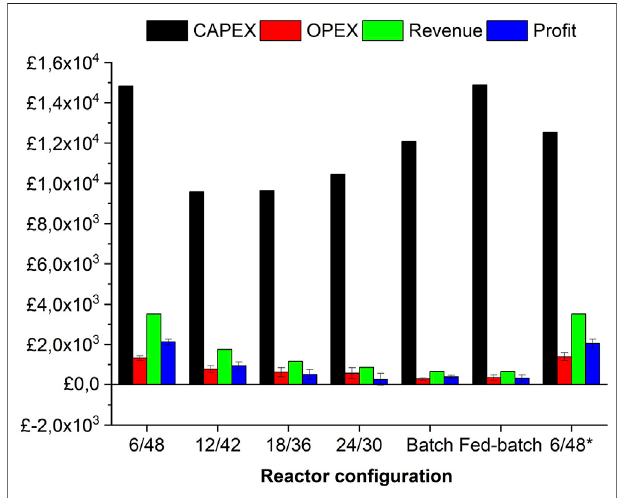
FIGURE 1 | Financial analysis (CapEx, OpEx, revenue, and pro fi t) of investigated con fi gurations at pilot scale. Error bars represent the standard